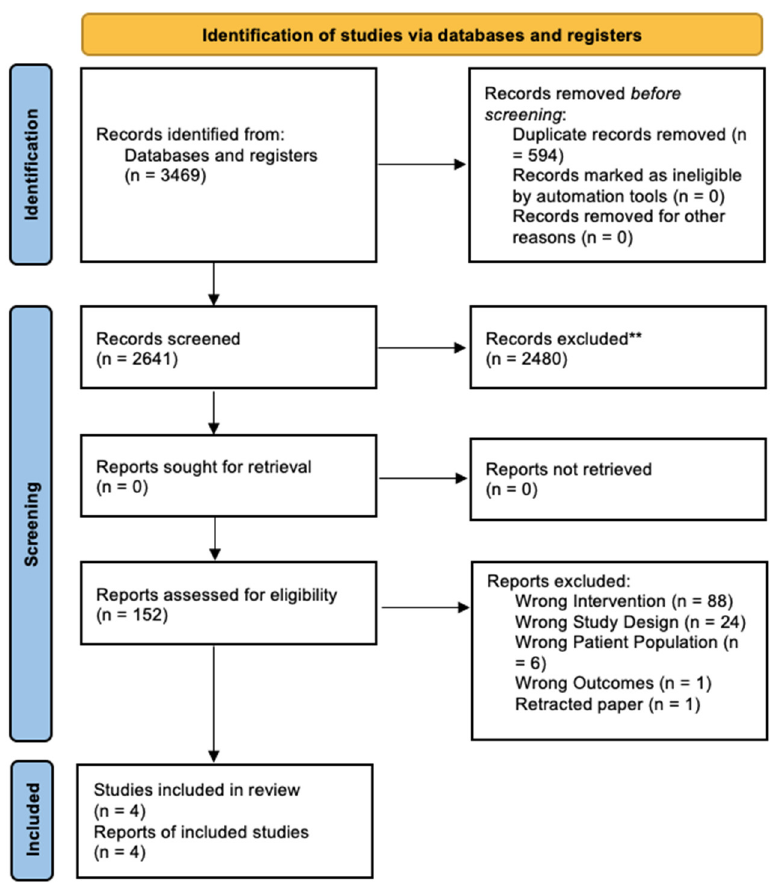
Figure 1. Flow of documents through the review process.